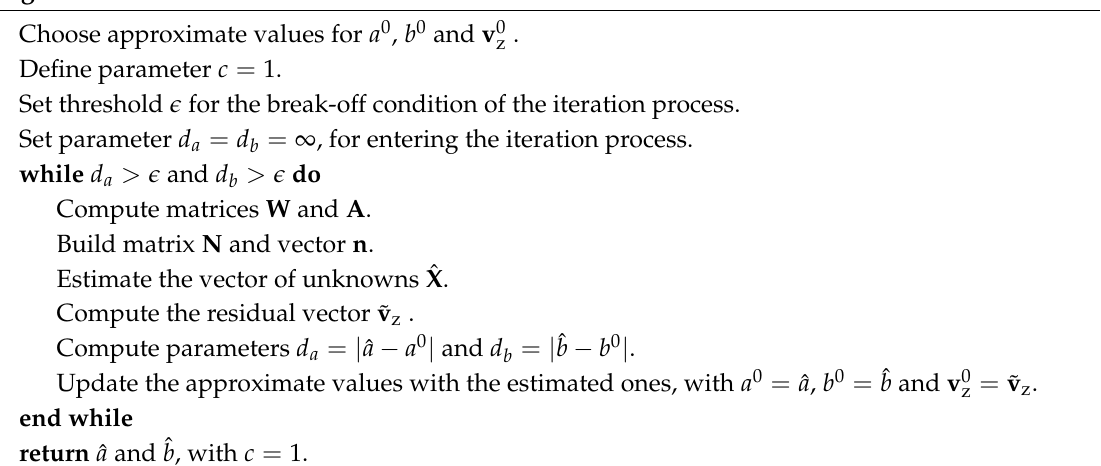
Algorithm 1 Iterative WTLS